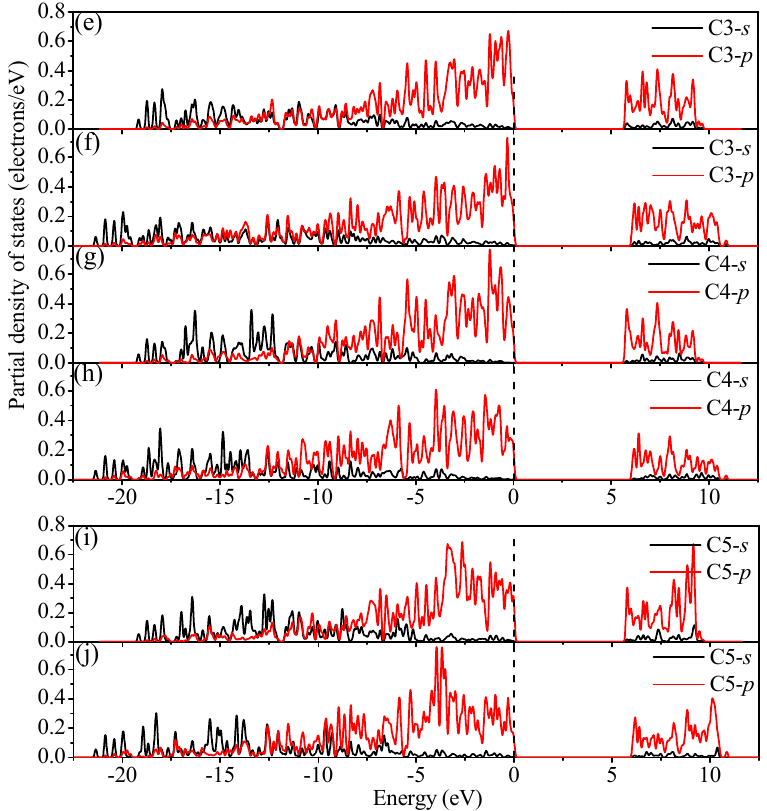
Figure 8. Partial density of state for I4 –carbon; ( a , c , e , g , i ) are at ambient pressure, while ( b , d , f , h , j ) are at 100 GPa.